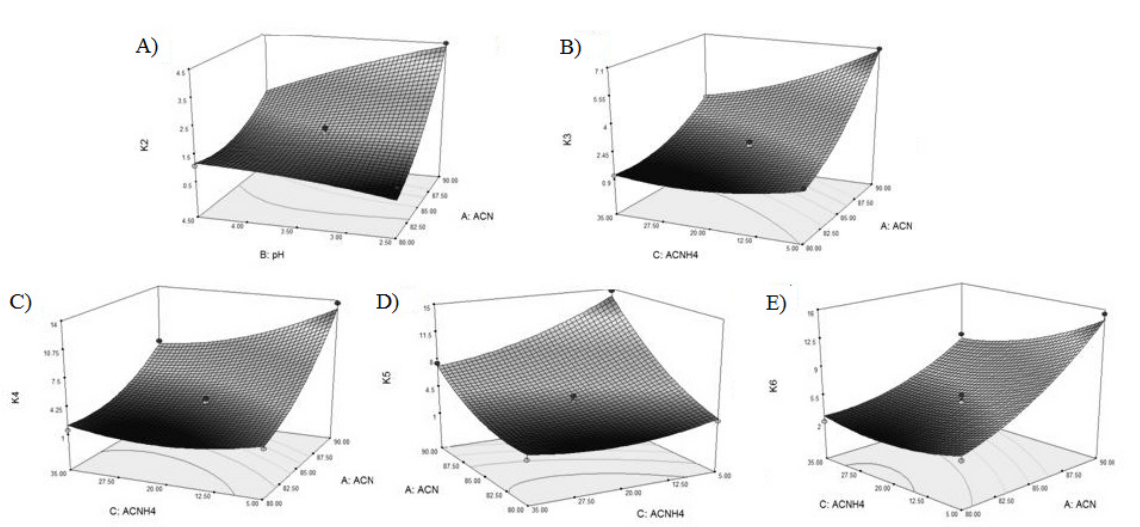
Figure 5. 3D response surface plots: A) k =f (acetonitrile concentration, pH of the aqueous phase); B) k 2 acetate concentration in the aqueous phase); C) k =f (acetonitrile concentration, ammonium acetate concentration concentration in 4